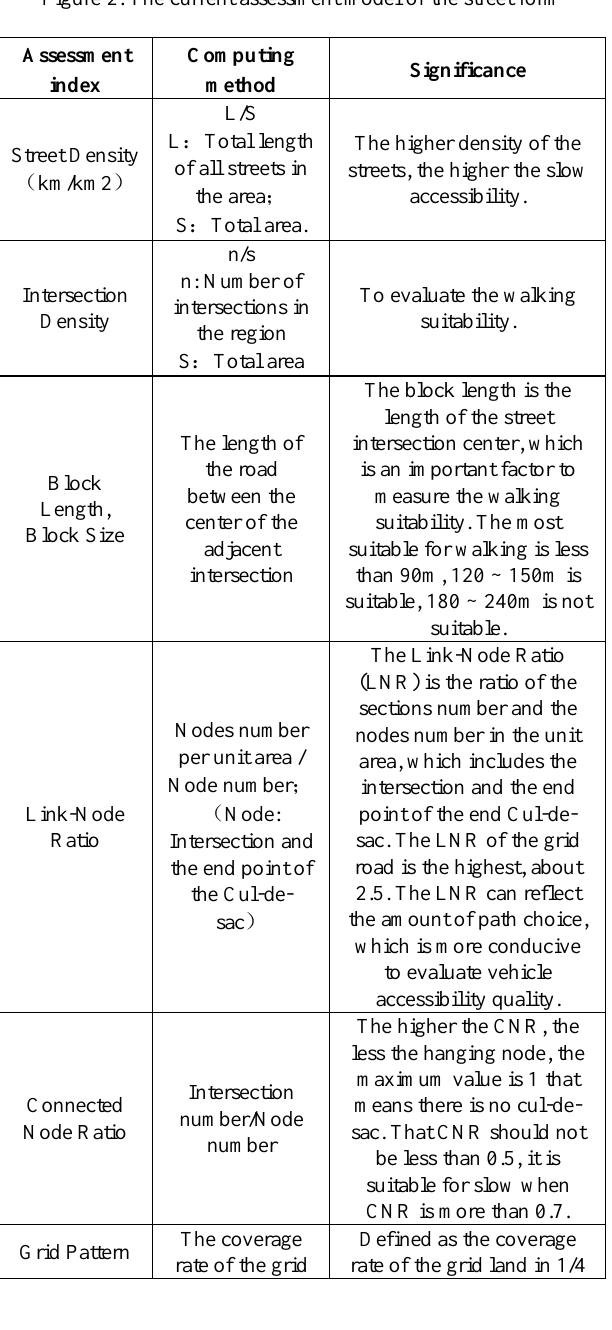
Figure 2. The current assessment model of the street form